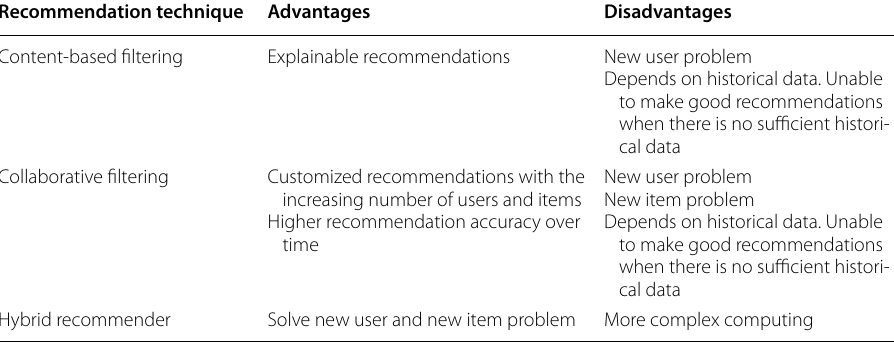
Table 2 Comparison of three recommendation approaches Recommendation technique Advantages